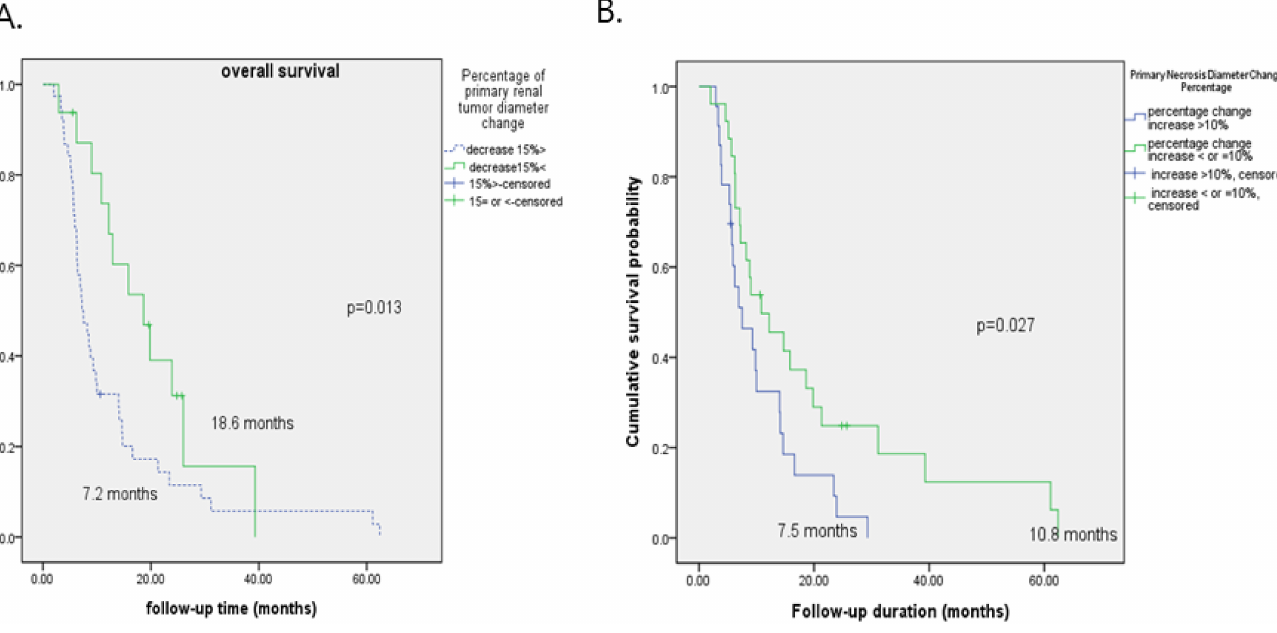
Fig 3. Overall survival curves comparing response groups according to the changes in the percentages of (A) the primary tumor diameter and (B) the primary tumor necrosis diameter from baseline computed tomography (CT) to first follow-up CT during first-line therapy.